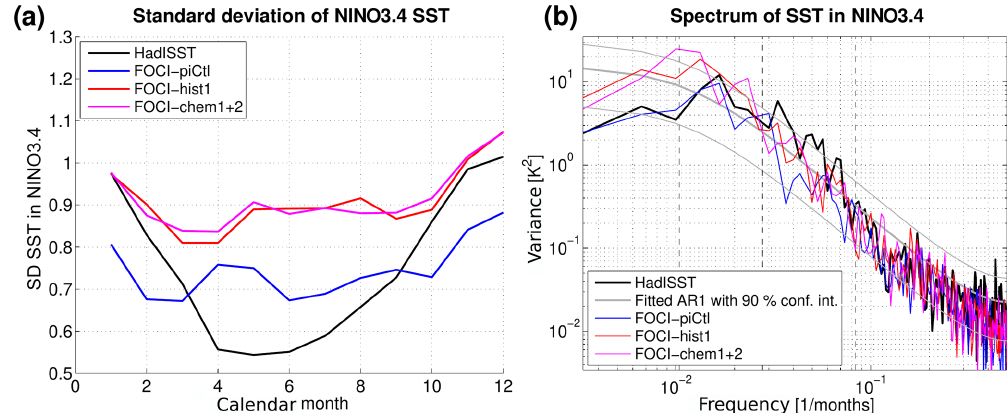
Figure 21. (a) Standard deviations of NINO3.4 SST index for each calendar month for HadISST for the period 1918–2017 and individual FOCI experiments for the last 100 years; (b) spectrum of SST variability in the NINO3.4 region compared to a fitted AR1 process; the dashed vertical lines mark the 1-, 3- and 8-year frequencies, respectively. As the FOCI-chem experiments are only 54 years long, the last 50 years of FOCI-chem1 and FOCI-chem2 are concatenated for this analysis.